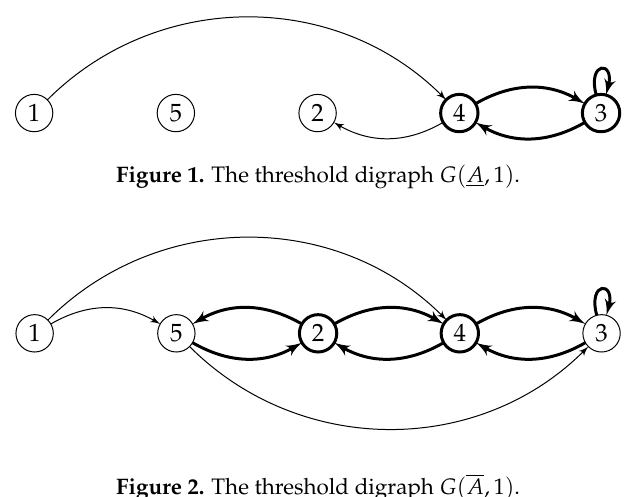
Figure 2. The threshold digraph G ( A ,1 )